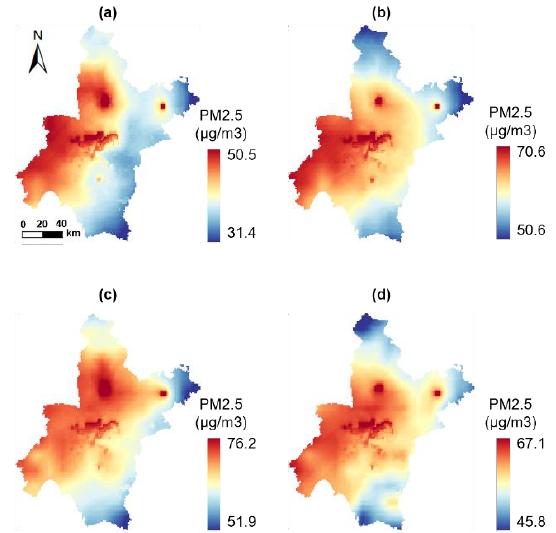
Figure 3. PM2.5 concentration of Wuhan in (a) 2000, (b) 2005, (c) 2010 and (d) 2015.